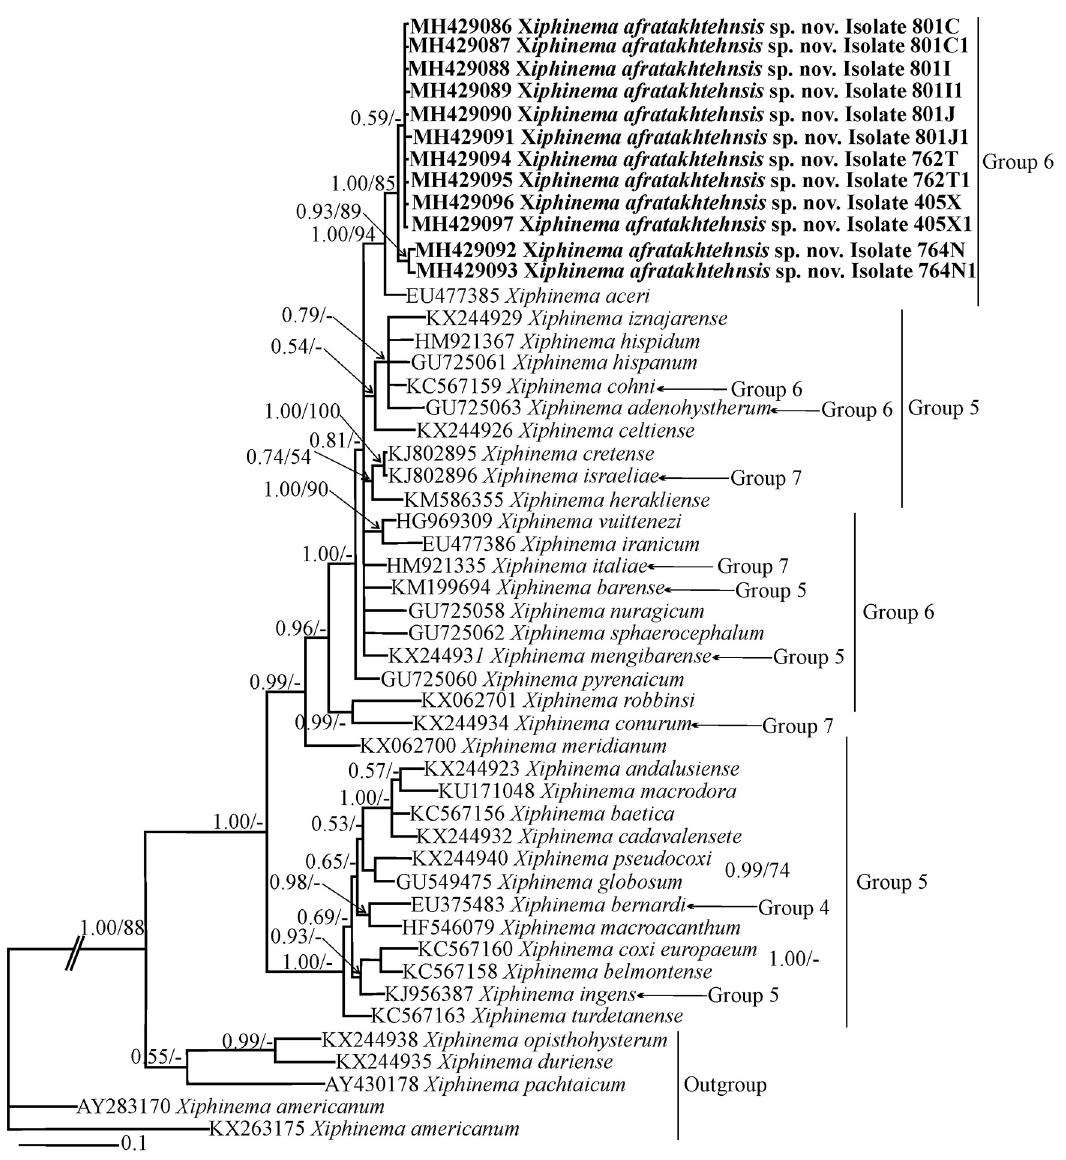
Fig 7. The 50% majority rule consensus trees from Bayesian inference analysis generated from the partial ITS1 rDNA dataset of Xiphinema afratakhtehnsis sp. nov. with the GTR+I+G model. Bayesian posterior probabilities and maximum likelihood bootstrap values are given for appropriate clades in the shape BPP/ML BS. Newly obtained sequences are in bold letters. Scale bar = expected changes per